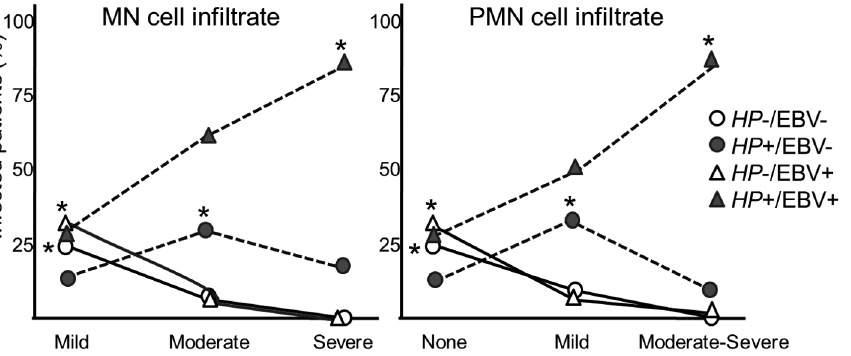
Figure 1. H. pylory and EBV infection frequencies in pediatric patients with gastritis according to the different grades of mononuclear (inflammation) and polymorphonuclear (activity) cell infiltration. Asterisks denote associations with statistical significance: HP 2 /EBV 2 and HP 2 /EBV + groups with mild MN and no PMN (open circle and triangle), HP + /EBV 2 (grey circle) with moderate MN and mild PMN, and HP + /EBV + (grey triangle) with severe MN and moderate-severe PMN.